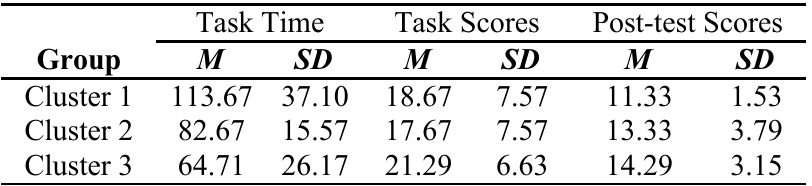
The Trends of Three Clusters for the Serialists